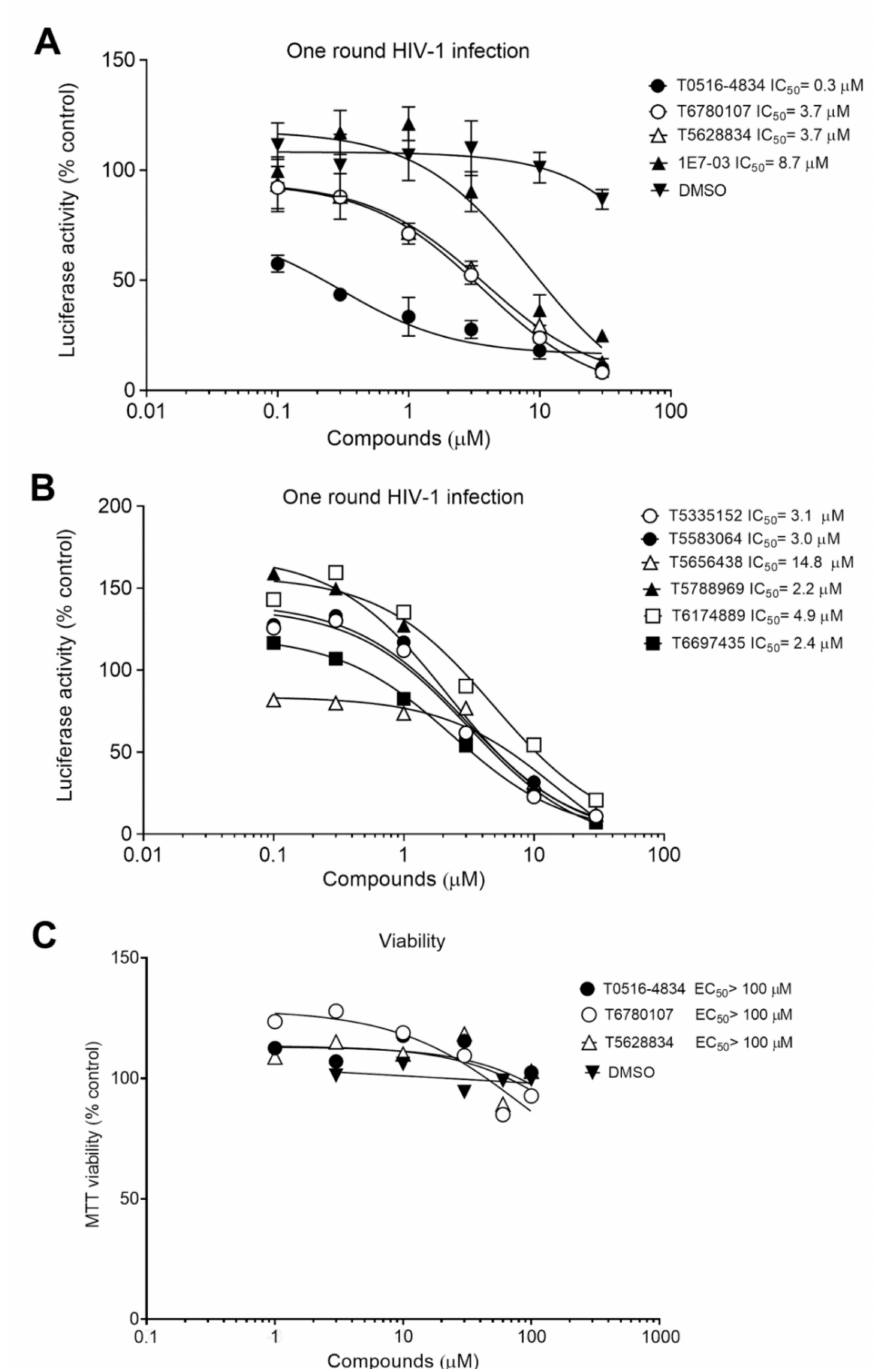
Figure 2. Dose-dependent HIV-1 inhibition by top candidate compounds. ( A , B ) CEM T cells were infected with HIV-1-LUC-G, then seeded in 96-well plate and treated with the indicated concentrations of the compounds. DMSO represents 100% and percentage of inhibition was calculated for each compound concentration. ( C ) CEM T cells were seeded in 96-well plates and treated with the indicated concentrations of the compounds. MTT was added and the formazan absorbance measure as described in Materials and Methods. DMSO represents 100% and percentage of viability was calculated for each compound